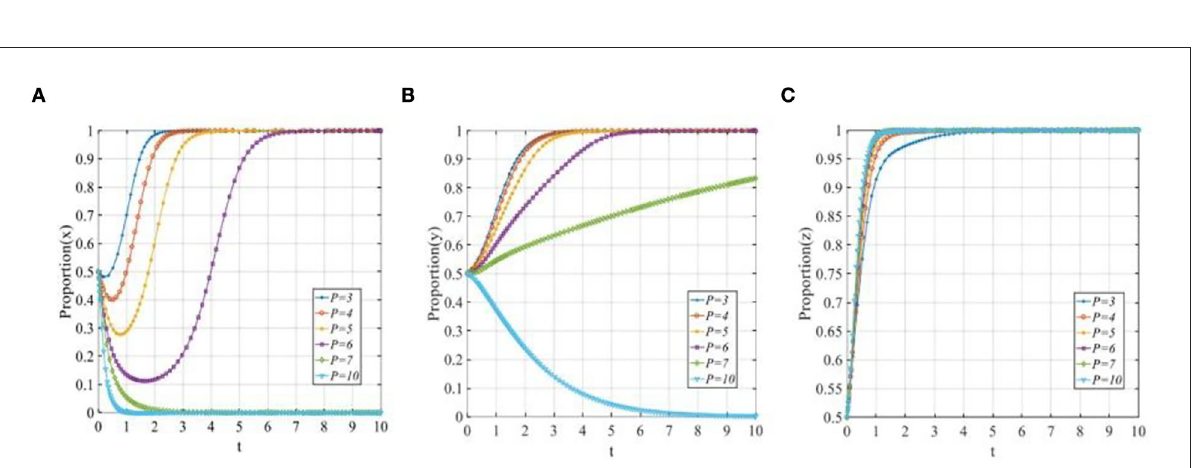
FIGURE14 The sensitivity analysis of the investment volume of investors when P = 3, 4, 5, 6, 7, 10. (A) The sensitivity of P2P lending platforms; (B) The sensitivity of investors; and (C) The sensitivity of financial